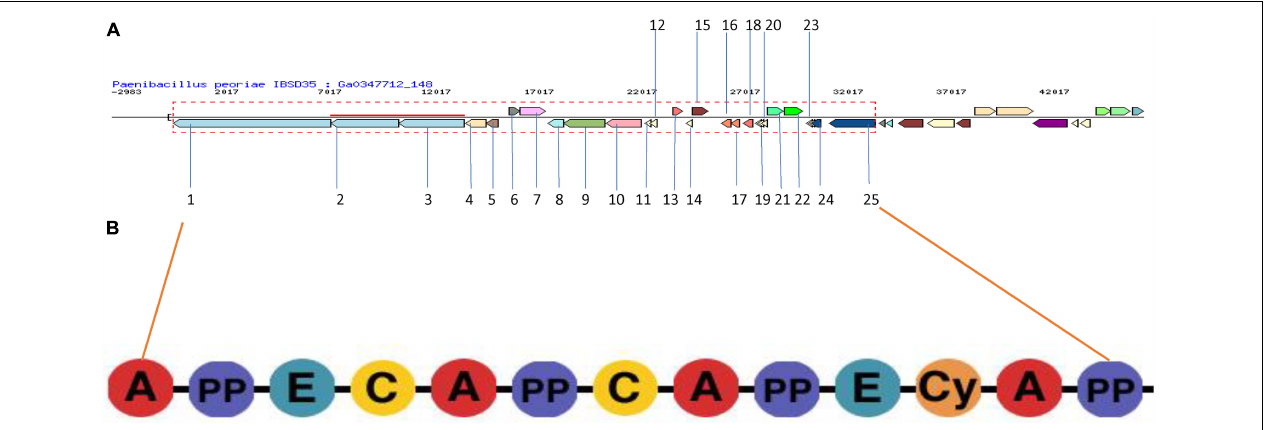
FIGURE 4 | (A) NRPS BGC in P. peoriae IBSD35 Neighborhood for Cluster ID 2816336725.Ga0347712_148.region1 predicted by JGI/ABC using AntiSMASH v5.0. The genes in the red dashed box are protocore genes in the clusters for pfam00068 condensation domain functions associated with this cluster. Genes are